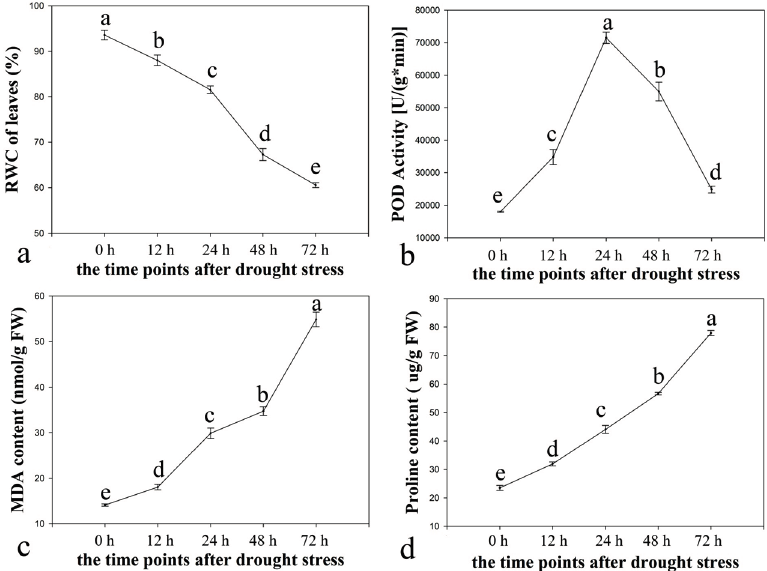
Figure 1. Four physiological traits of leaves from ramie seedlings under drought stress. ( a ) the RWC of leaves; ( b ) the POD activity; ( c ) the MDA content; ( d ) the proline content. The leaves were harvested at 0, 12, 24, 48, and 72 h after treatment with 15% ( w / v ) PEG6000. The error bars mean standard error. a, b, c, d, and e indicated significant differences ( p < 0.05) among different